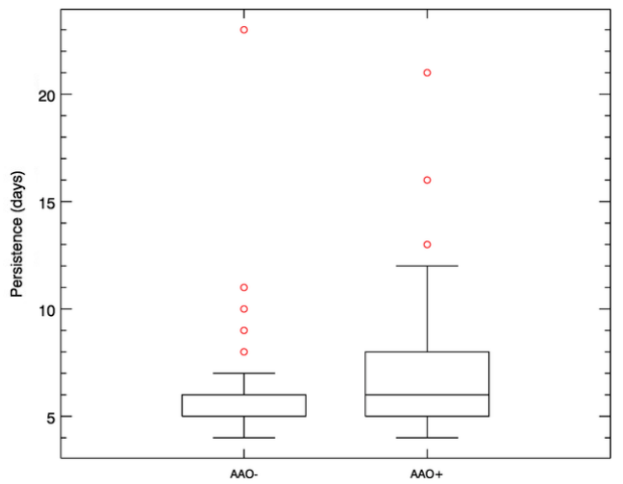
Figure 4. Boxplot of persistence (days) of SACZ events in AAO − and AAO+. The red circles represent the outliers, the box represents the interquartile range (IQ), the upper whisker is given by the upper quartile +1.5 × IQ, and the lower whisker is given by the lower quartile –1.5 × IQ.